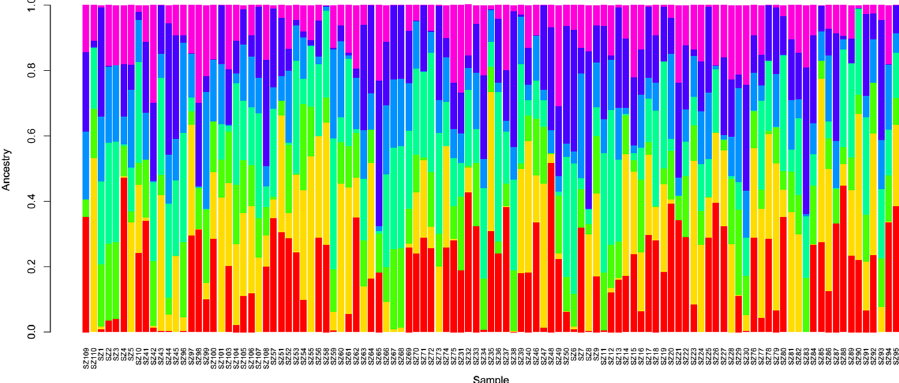
Figure 4. Population structure. The x-axes indicate individual plant accessions and y-axes means ancestries of each individual plant accessions.